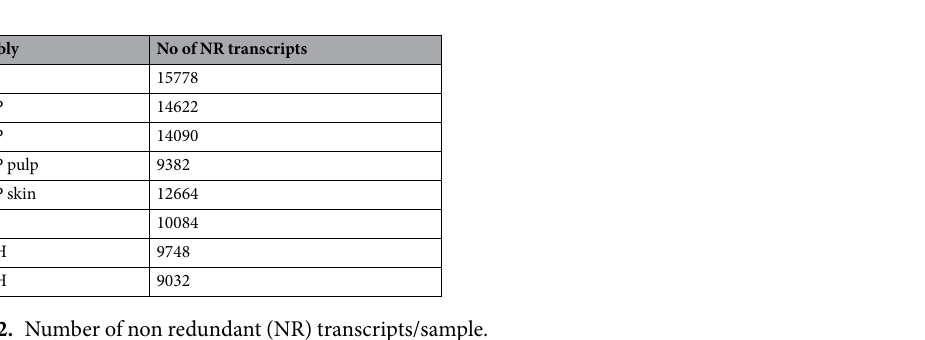
tissue. Evaluation of differentially expressed transcripts between pulp and skin of 90 DAP revealed very few